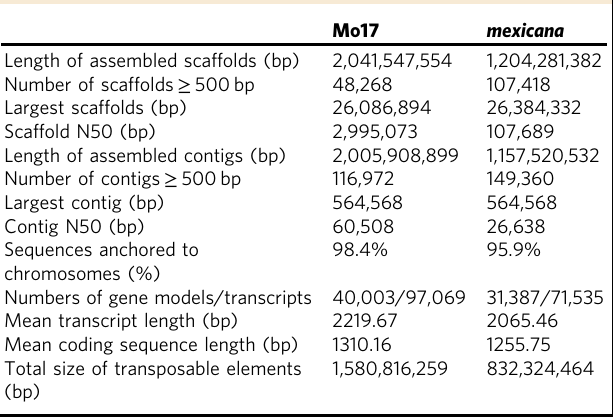
Table 1 Characteristics of the Mo17 and mexicana genome sequences